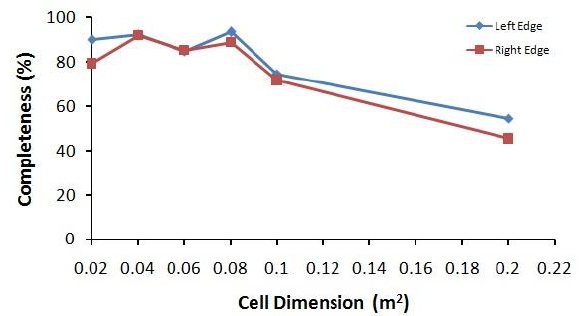
Figure 7: Plot of completeness obtained from the snake curve in the six test cases of raster cell dimension